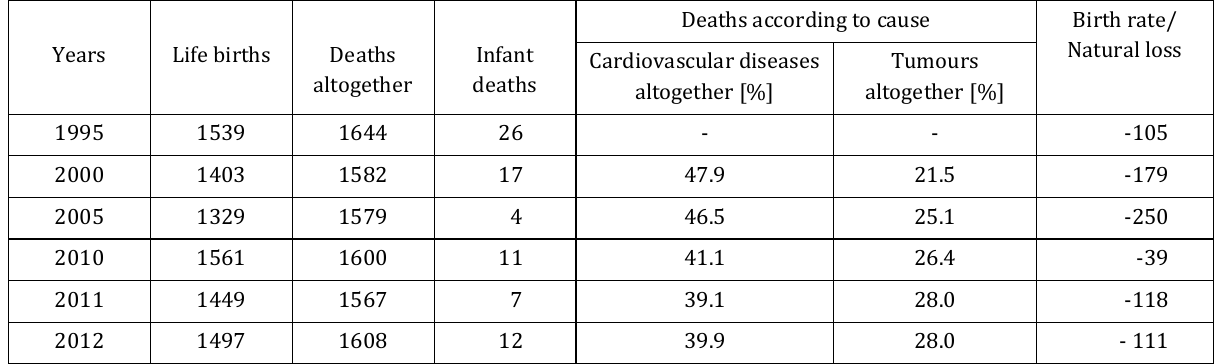
Table 2. Natural movement in Ruda Śląska (by Rocznik statystyczny, 1995; www.stat.gov.pl/gus, 1995-2012)